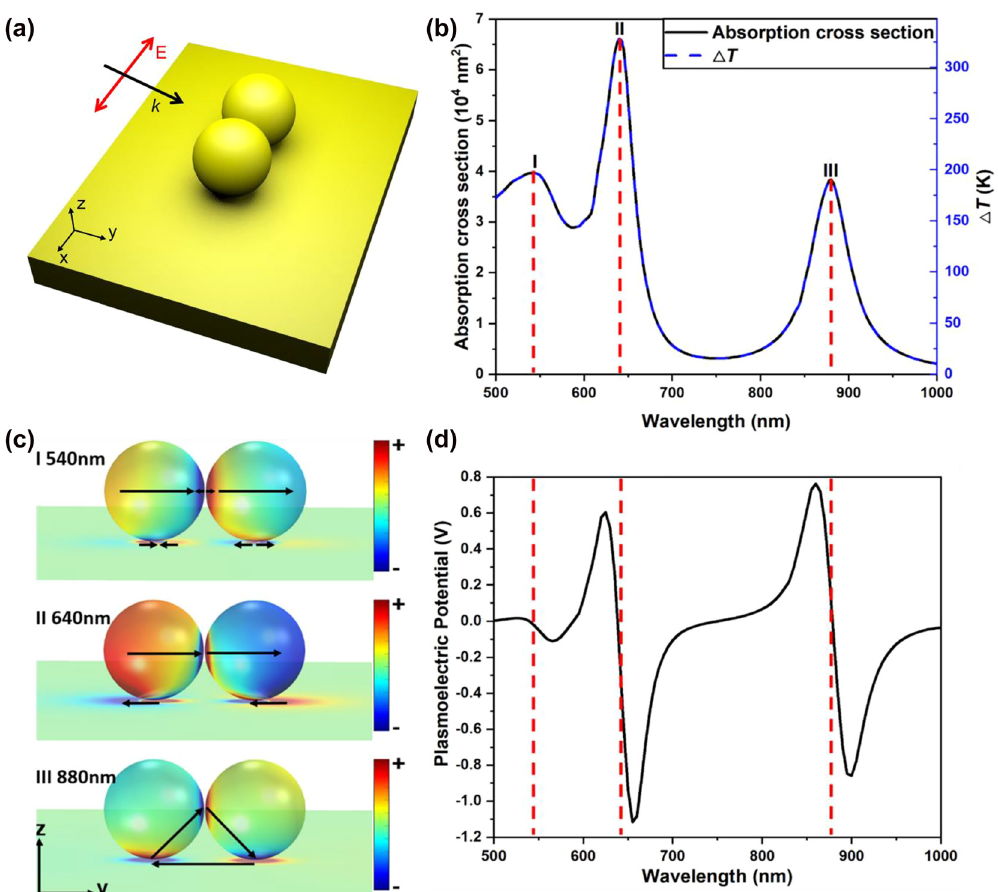
Figure 3: Temperature rise and PEP induced by hybridized plasmonic mode from gold dimers. (a)Schematic,(b)absorptionspectrum(leftaxis)andtemperaturerise(rightaxis)ofagoldnanospheredimercoupledtoagold fi lm.Eachgold nanosphere is 50 nm in radius and coated by a 1 nm thick citric acid, resulting in an interparticle gap of 1 nm and a particle- fi lm distance of 1nm.(c)SimulatedsurfacechargedistributionatthethreeplasmonmodesI,II,andIIImarkedin(b).(d)CalculatedPEPspectrumofthesystem in (a) under optical illumination with incident optical intensity 0.1 MW/cm 2